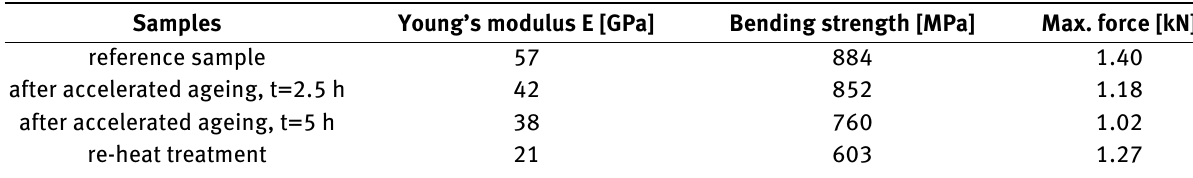
Table 7: Results of the 4PBT